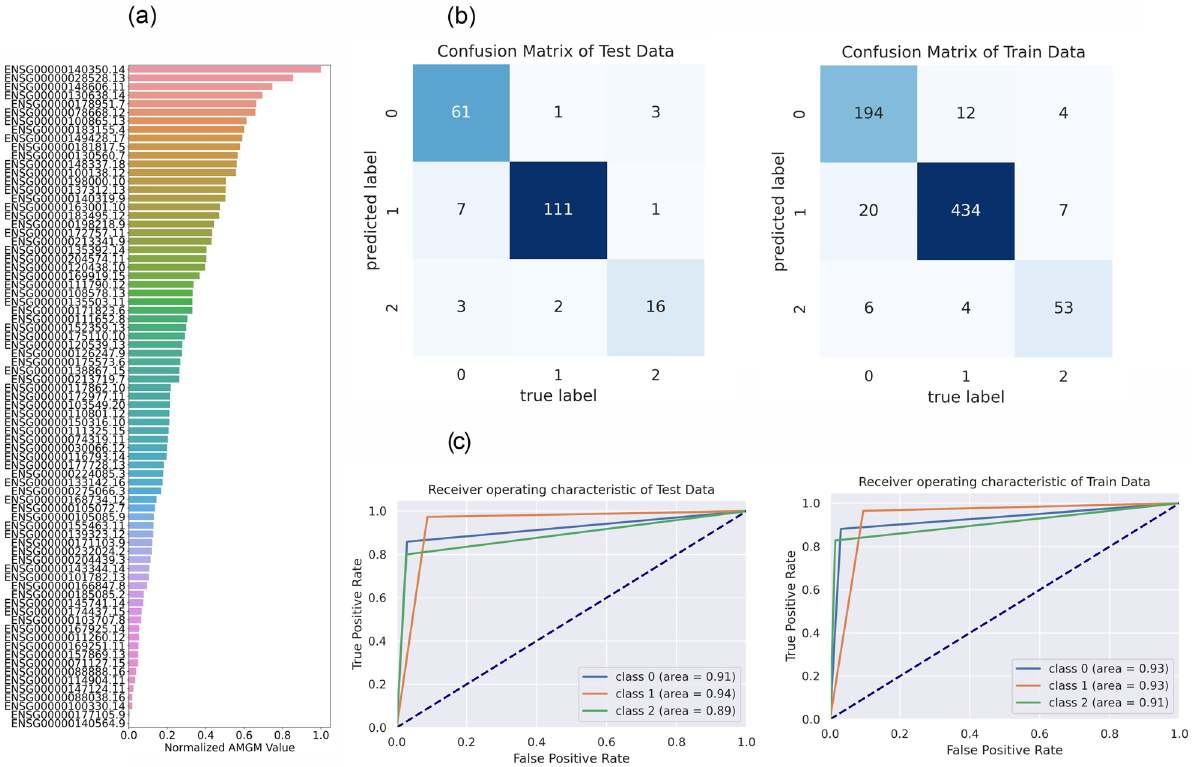
Figure 3. The presentation of feature selection and classification steps in the mRNA data. ( a ) Candidate mRNAs (77) are presented by Bar plot based on normalized AMGM values. ( b ) Training and test data confusion matrix. ( c ) ROC curve of training and test data. The AUC-ROC is reported for each curve. 0, 1, and 2 are pointed to KIRP, KIRC, and KICH groups, respectively. AUC‑ROC Area under the Curve of Receiver Operating Characteristic.